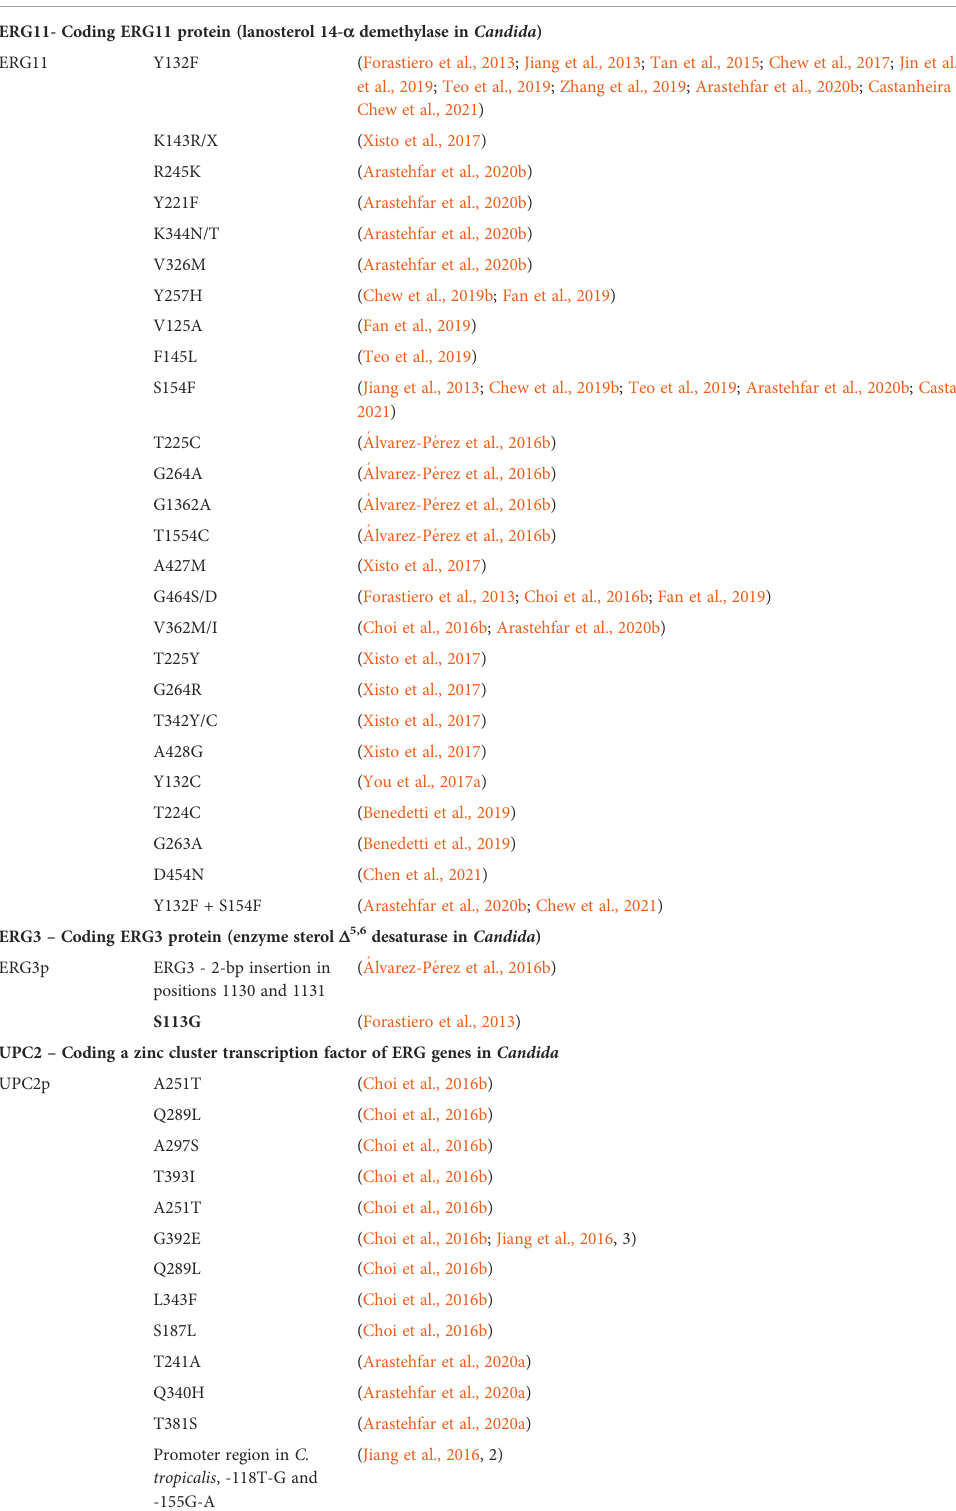
TABLE 1 Molecular mechanisms of resistance to fl uconazole or echinocandins in C. tropicalis from invasive fungal infections.